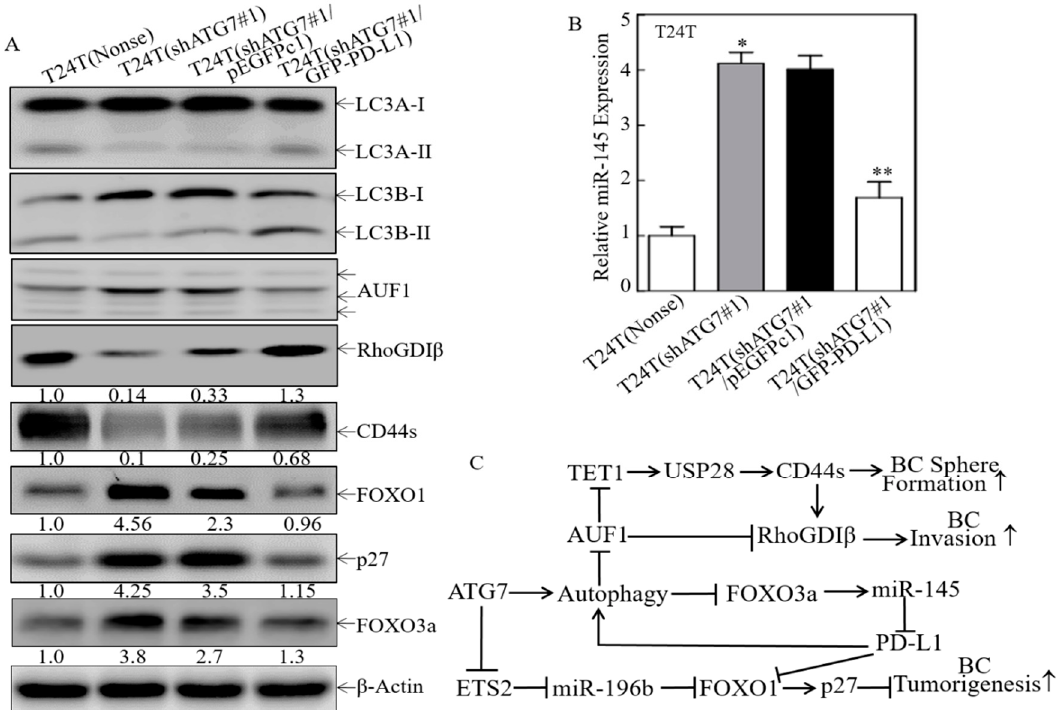
Figure 7. A positive feedback loop was formed to promote PD-L1 expression and ATG7/autophagy downstream effects in human BC cells. ( A ) T24T(shATG7#1) cells were stably transfected with the GFP-tagged PD-L1 overexpression plasmid, Western Blot was performed to determine the conversion of LC3 from LC3-I to LC3-II and the expression of AUF1, RhoGDI β , CD44s, FOXO1, p27, and FOXO3a. β -Actin was used as a protein loading control. ( B ) Real-time PCR was performed to evaluate miR-145 expression in the indicated cells. * p < 0.05; ** p < 0.05. ( C ) The proposed mechanisms underlying